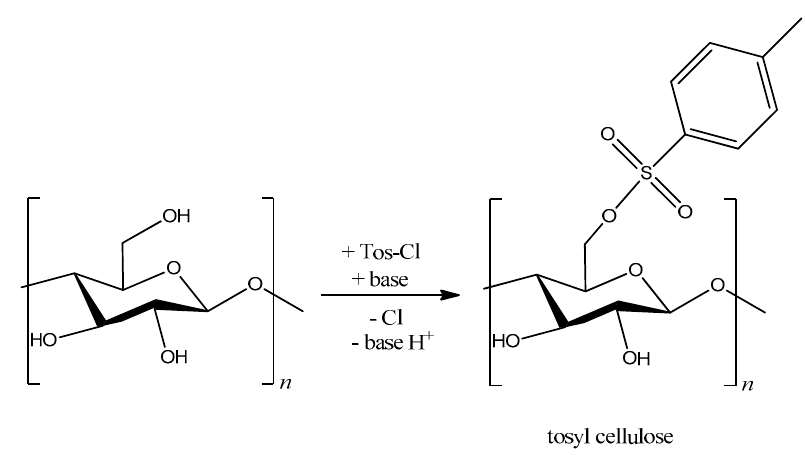
Figure 4. Tosylation of cellulose with tosyl chloride. Reprinted with permission from [174]. Copyright 2012 Elsevier.